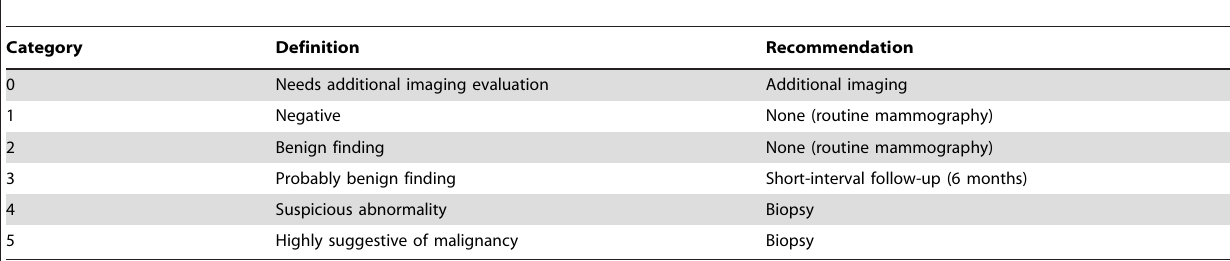
Table 1. BI-RADS* final assessment categories with associated